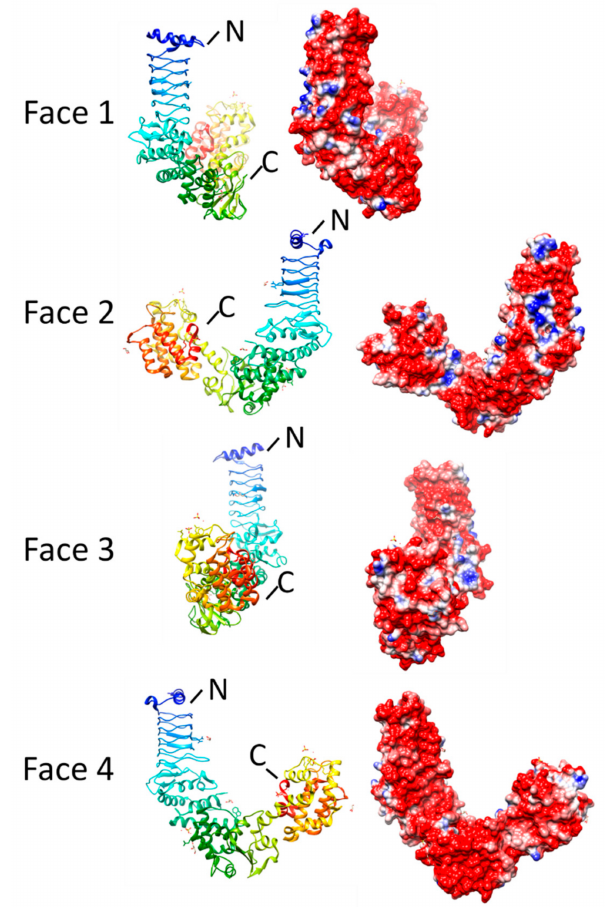
Figure 11. Structure and analysis of NleL. Ribbon diagrams of the structure (PDB ID: 3NAW) for four different orientations (at left) and the corresponding electronic potential surface plots (at